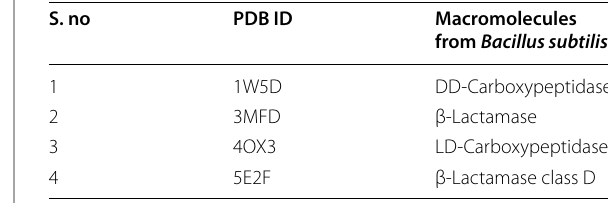
Table 1 Macromolecules chosen from Bacillus